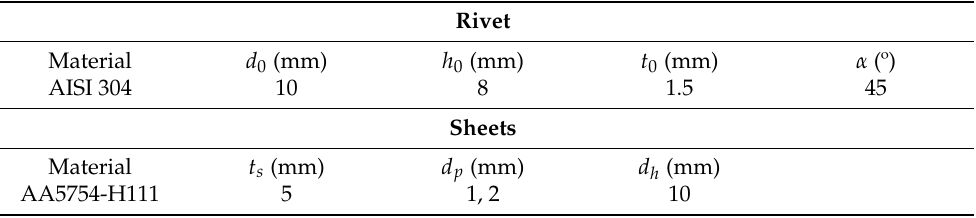
Table 1. Operating process parameters utilized in the experimental and numerical evaluation of different possible strategies of DSSPR (refer to Figure 3).